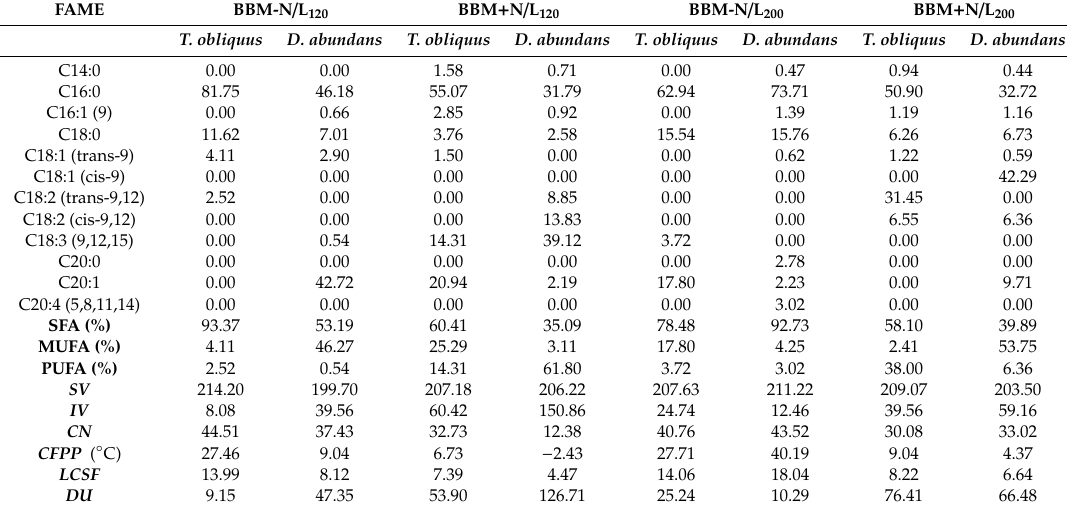
Table 2. FAME profile of the two green microalgae that showed the highest lipid yields in di ff erent culture